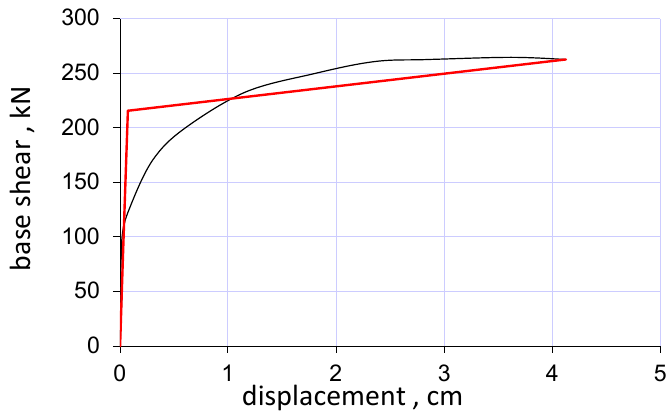
Figure 16. The two-line graph resulting from the cyclic loading curve.